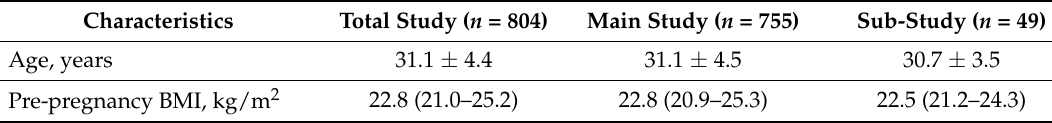
Table 1. Sample characteristics of the pregnant women a